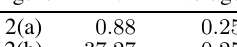
Table 2. Estimates of the equivalent number of looks for both images from Figure 3.